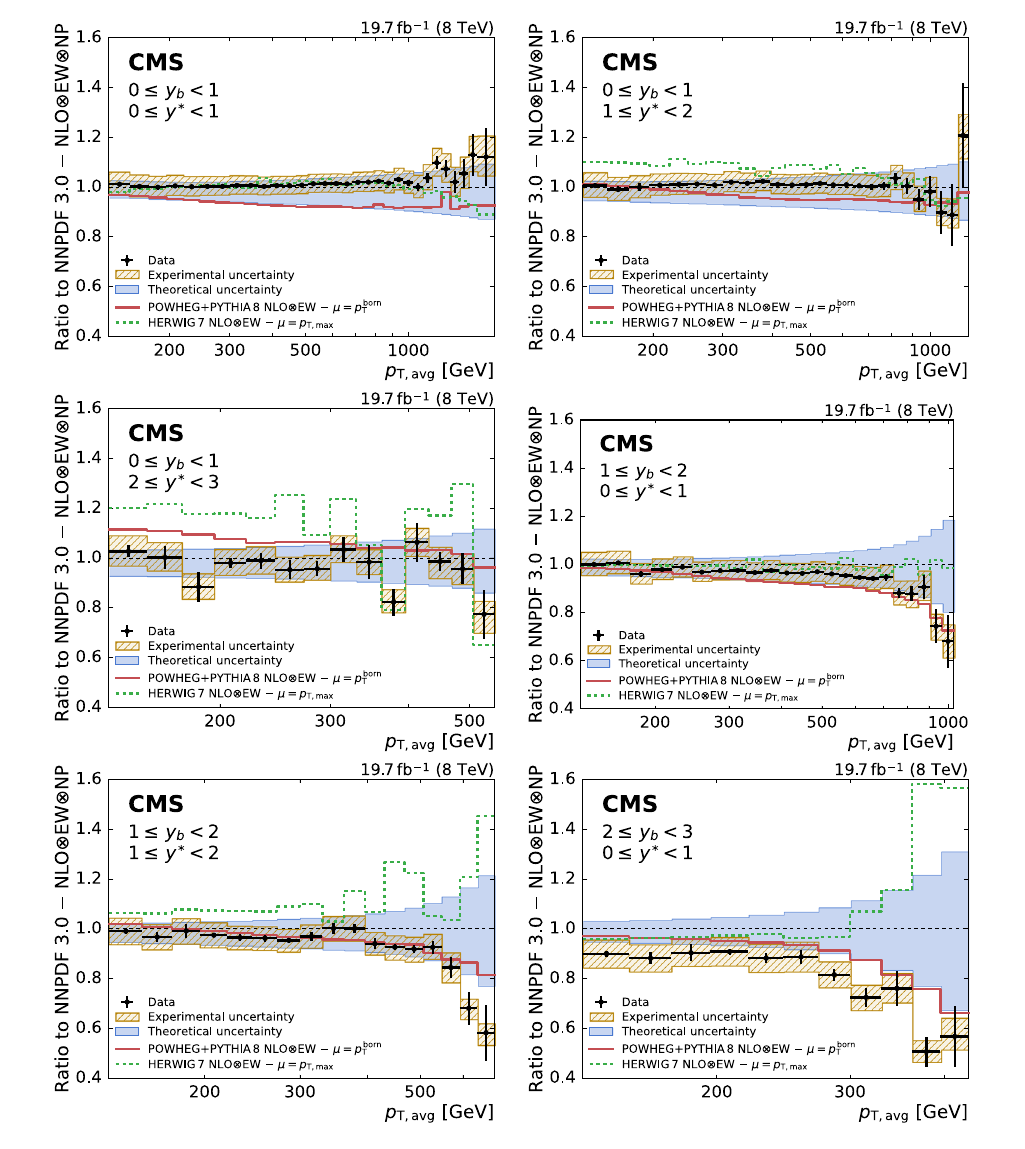
Fig. 8 Ratio of the triple-differential dijet cross section to the NLO- Jet++ prediction using the NNPDF 3.0 set. The data points including statistical uncertainties are indicated by markers, the systematic exper- imental uncertainty is represented by the hatched band. The solid band